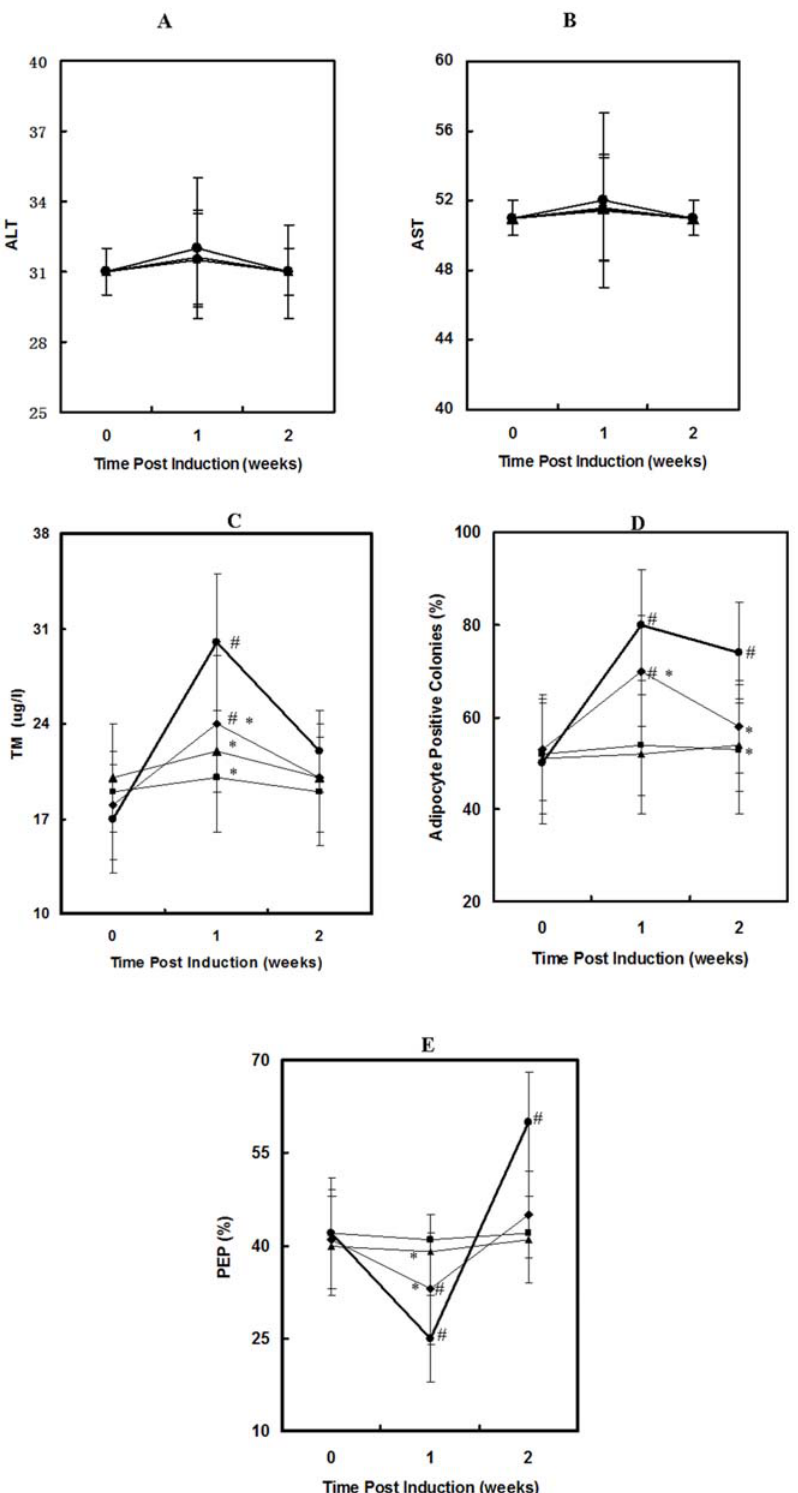
Figure 2. Hematology/cytology/MRI data analysis. There was no significant change from baseline in ALT (A) and AST (B) when compared to the CON group. Significantly increased TM (C) from baseline in the CON group was attenuated in the L-EF group or prevented in both the M-EF and H-EF group at week 1 post induction, and adipocyte positive colonies (D) in the CON group were attenuated in the L-EF group or prevented in both the M-EF and H-EF group after induction. In addition, the significantly decreased PEP (E) from baseline in the CON group was attenuated in the L-EF N group or prevented in both the M-EF and H-EF group at week 1 post induction. Note: * P , 0.05 for comparison with CON; # P , 0.05 for comparison CON group; X L-EF group; & M-EF group; m H-EF group. with baseline.